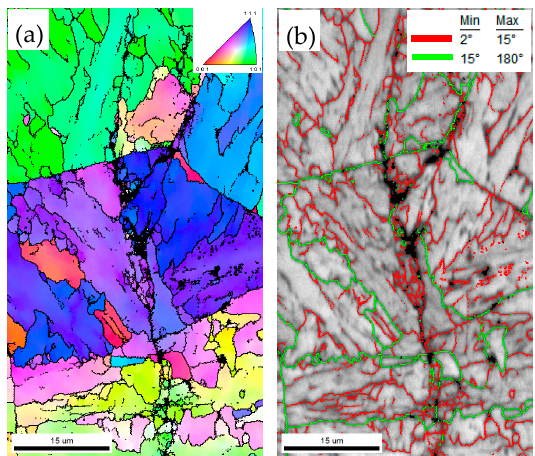
Figure 11. Crystallographic characteristics of the fatigue cracks at peak temperature of 1350 °C. ( a ) Orientation image maps; ( b ) Image quality maps with grain boundary misorientation distribution.